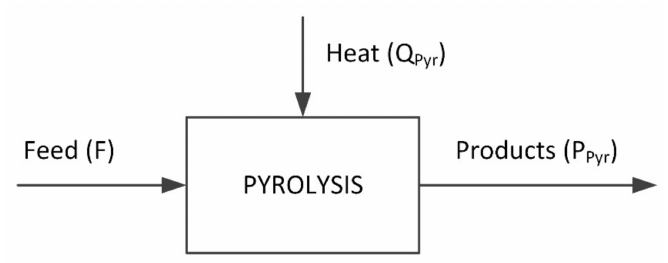
Figure 12. The flow diagram for energy balance of